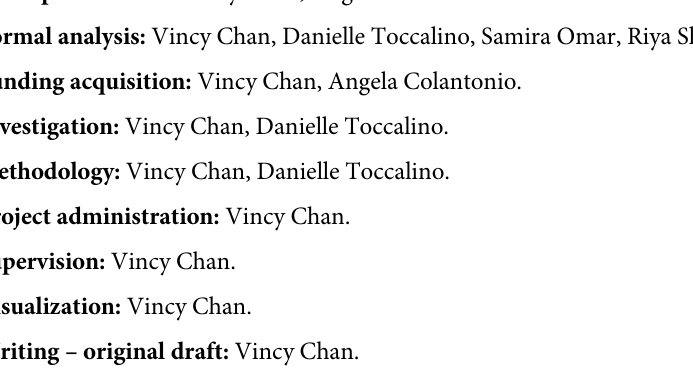
S1 Table. Data extraction